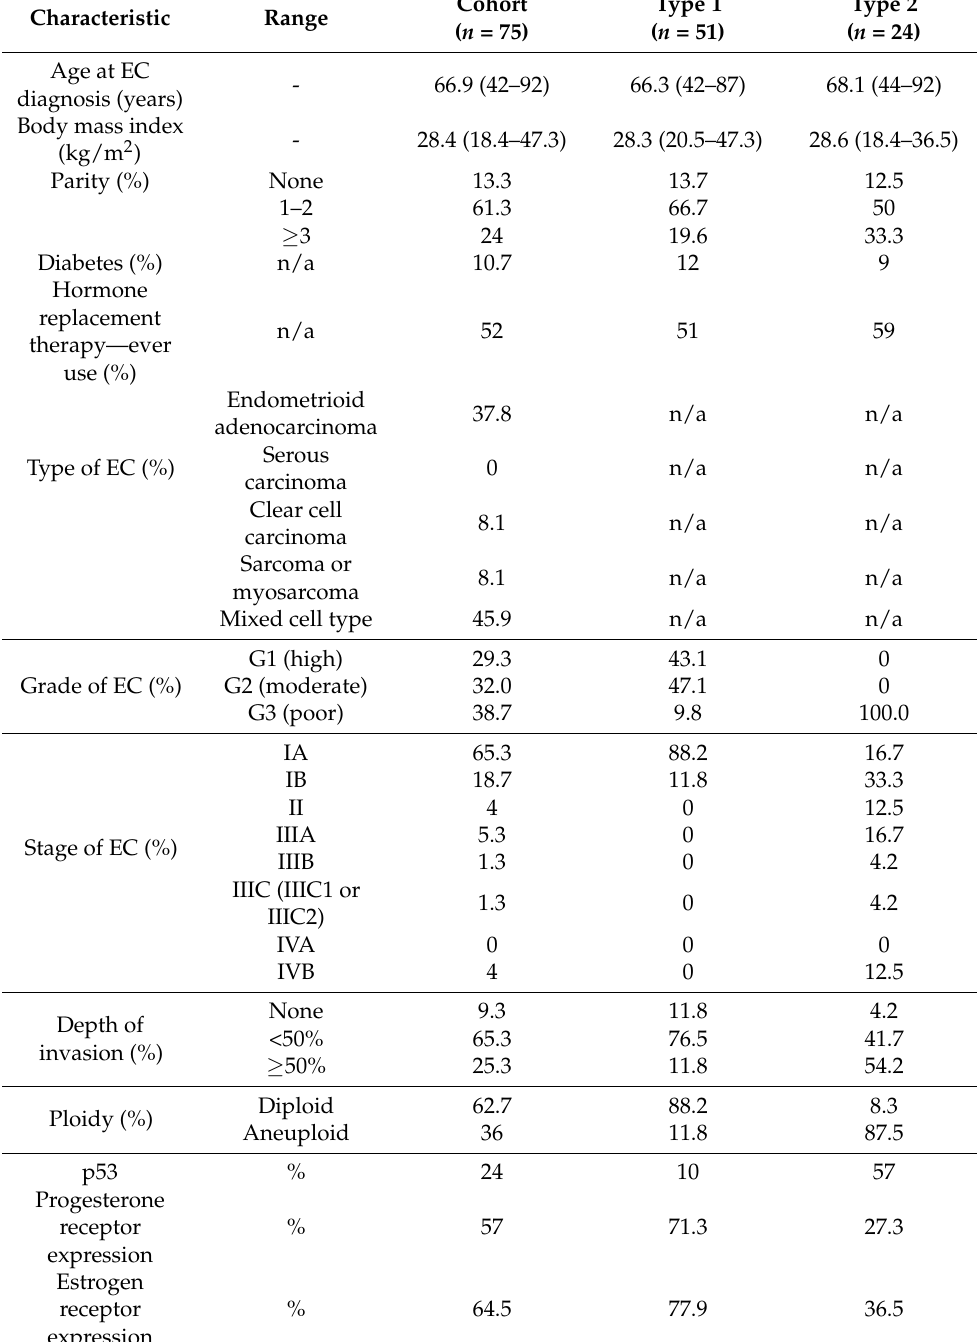
Table 1. Characteristics of the analytical sample at endometrial cancer diagnosis and characteristics of corresponding endometrial cancer biopsies ( n =